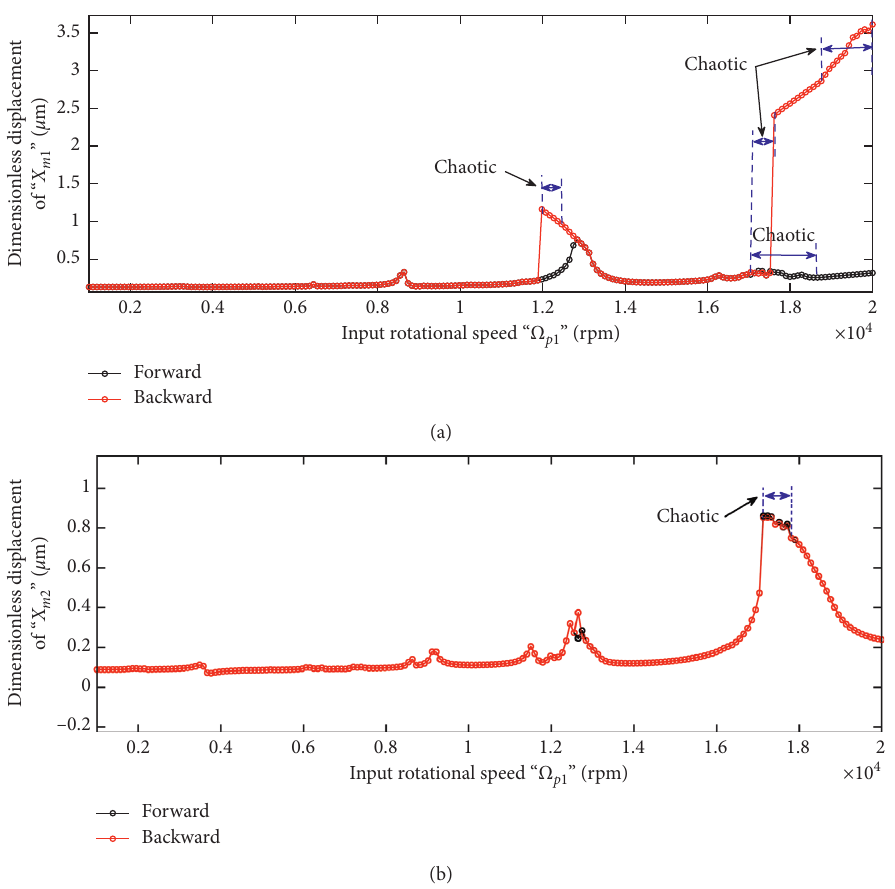
Figure 9: PPVs of forward and backward behaviors of system; s